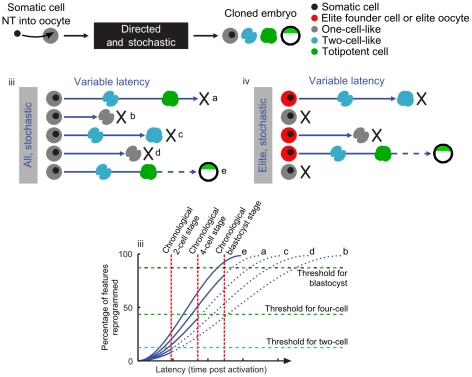
Proposed model of reprogramming mode, adapted from Hanna et al. [8].After NT, reprogramming proceeds with directed and stochastic components (A) with variable latency to yield embryos of different developmental stages (B). Due to the stochastic component of the reprogramming process, some embryos have been reprogrammed more than others at a certain point in time (C). If a critical reprogramming threshold of genes essential for the respective chronologically timed embryonic stage is not reached, the embryo halts development (C). It cannot be excluded that certain oocytes reprogram better than others (elite oocytes, D), for example due to higher levels of certain factors of the “reprogrammome” [61].